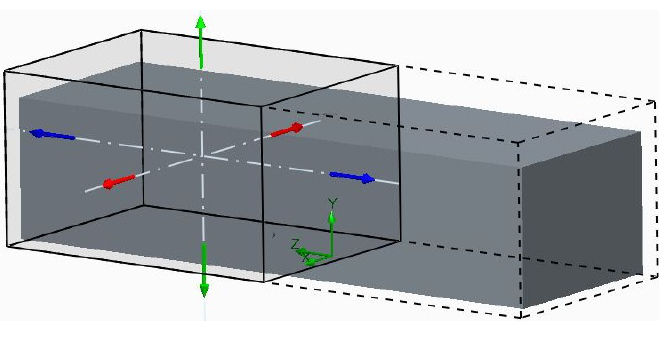
Figure 12. The dumpster model in FloEFD with the computational domain (solid lines) set to encompass half the total volume. The domain boundary on the X-Y plane